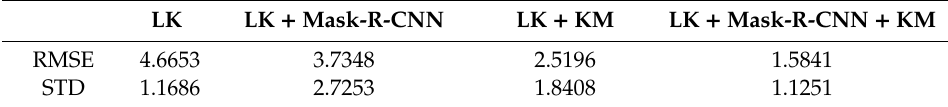
Figure 11. ( a ) Velocity error in X direction of experiment 2; ( b ) velocity error in Y direction of experiment 2. Table 6. Velocity errors of four algorithms in the Y direction. Table 5. Velocity errors of four algorithms in the X direction.